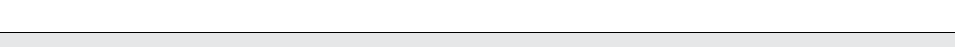
Table 2. Themes Emerging from the Research